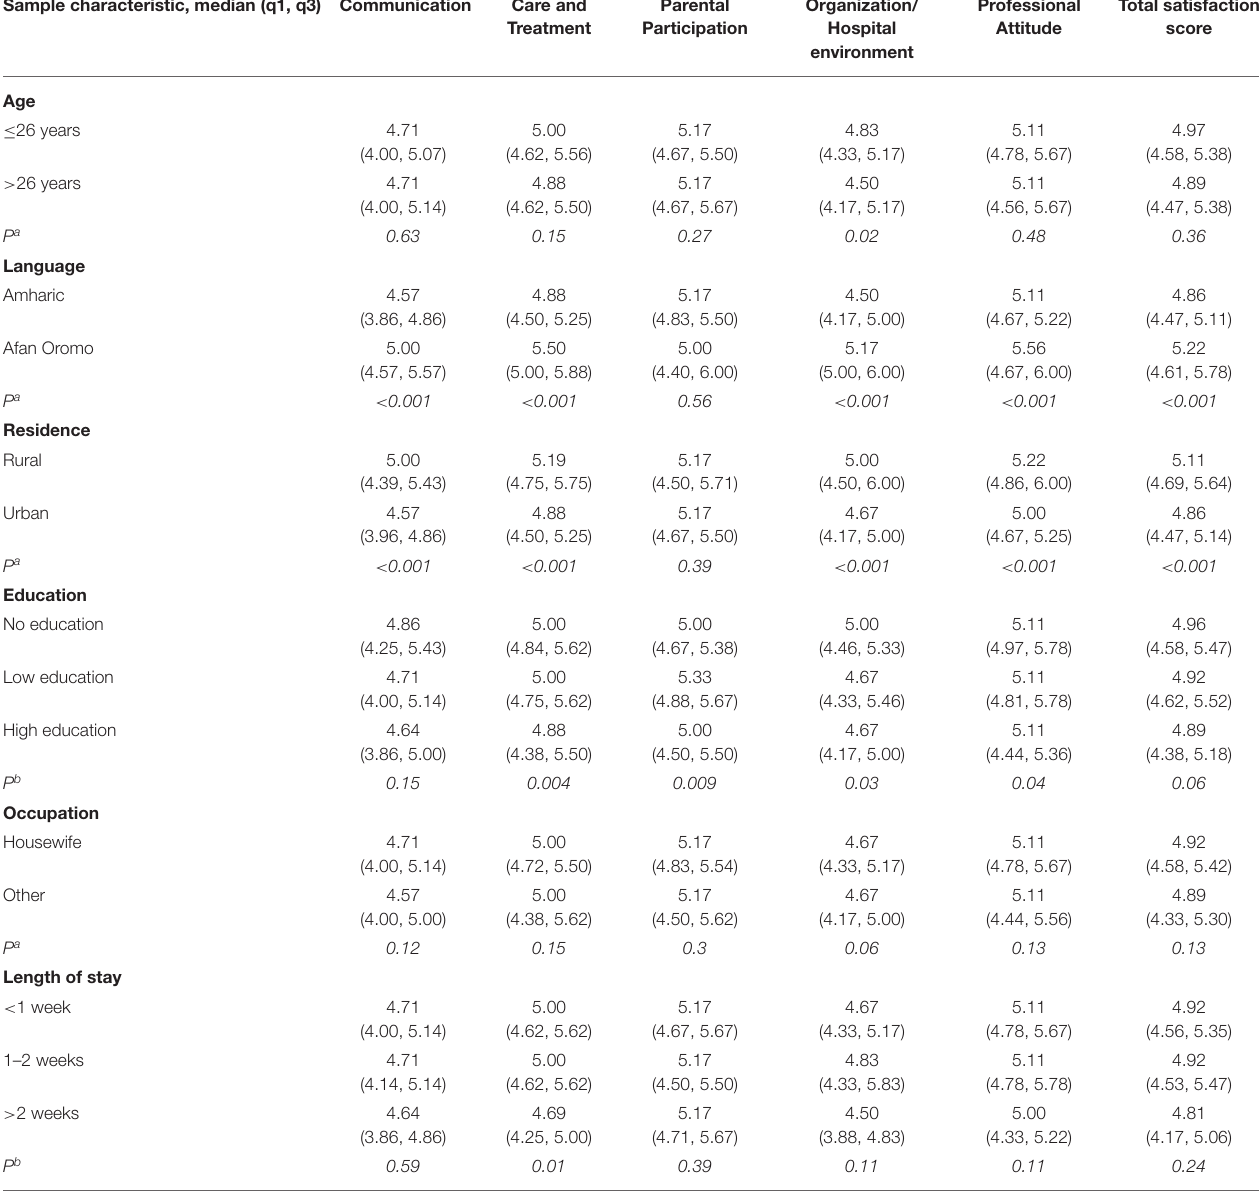
TABLE 5 | Statistics of the domain scores according to participants’ characteristics. Sample characteristic, median (q1, q3)